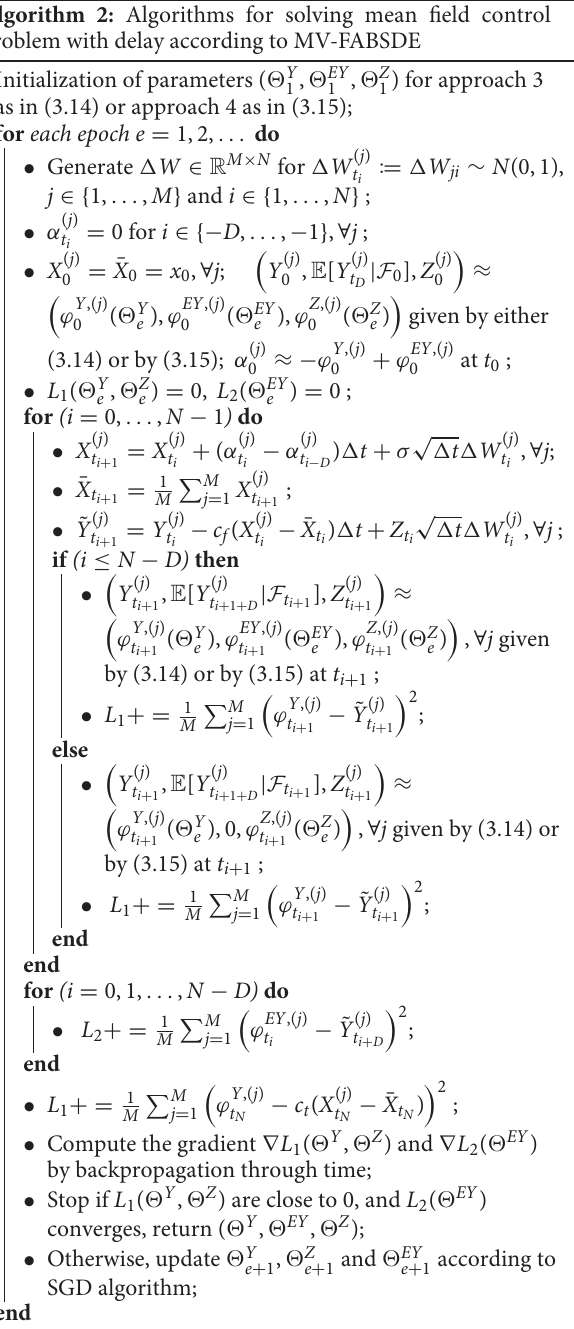
Algorithm 2: Algorithms for solving mean field control problem with delay according to MV-FABSDE Initialization of parameters ( 2 Y as in (3.14) or approach 4 as in